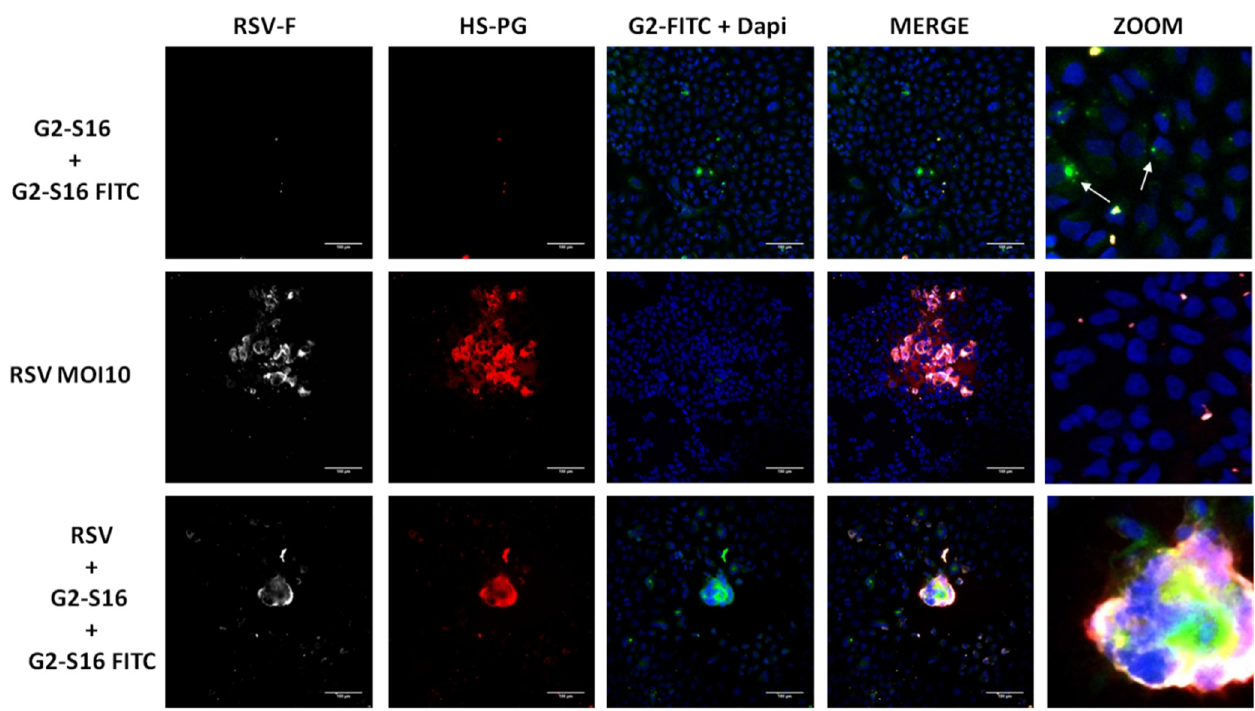
Figure 4. Presence of G2-S16 dendrimer in syncytium formation . A549 cells were infected with RSV at MOI 10 and treated with a mix of G2-S16 (5 µM) and G2-S16 FITC (5 µM) dendrimers. Then, 72 h post-infection, A549 cells were fixed and immune-stained for RSV-F glycoprotein (white), HSPG (red), and DAPI nuclei visualization (blue). Images are representative of three independent experiments.